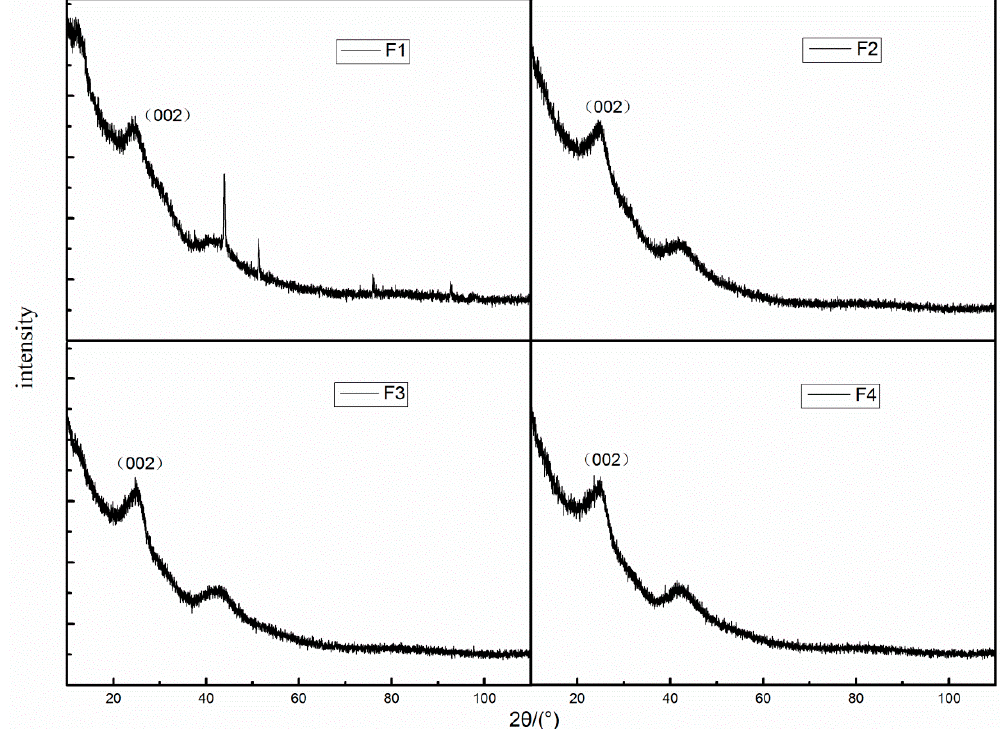
Figure 6. XRD spectra of nascent soot particles under different conditions: (F1) pure ethylene; (F2) 1-pentanol/ethylene; (F3) 3-methyl-1-butanol/ethylene; and (F4) 2-methyl-1-butanol/ethylene.